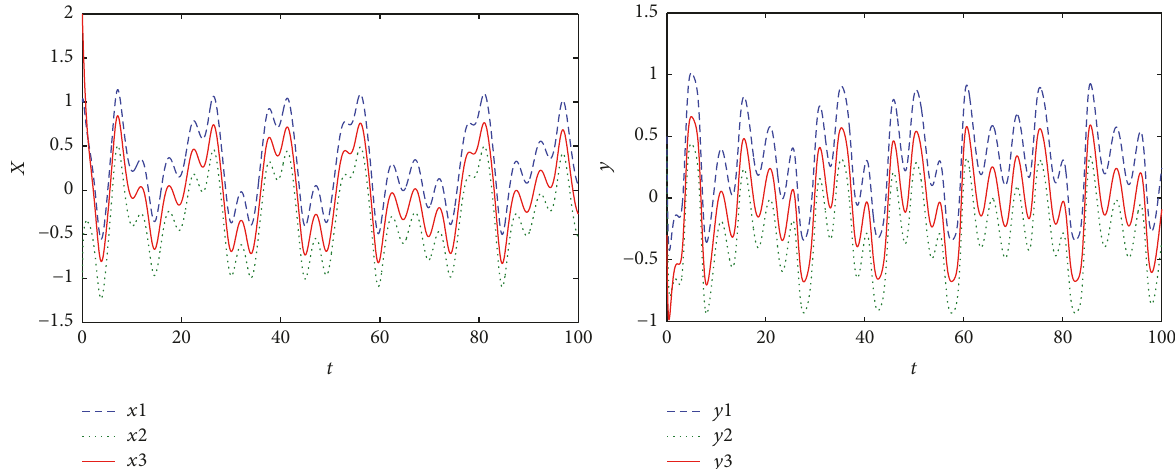
Figure 2: Phase synchronization of three Duffing systems for initial points (𝑥 1,0 ,𝑦 1,0 ) = (1,0.5) , (𝑥 2,0 , 𝑦 2,0 ) = (−1,0.4) , and (𝑥 3,0 , 𝑦 3,0 ) = (2,−0.3) and parameters 𝑎 = 𝑏 = 0.35 , 𝑐 = 0.3 , and 𝑑 = 0.2